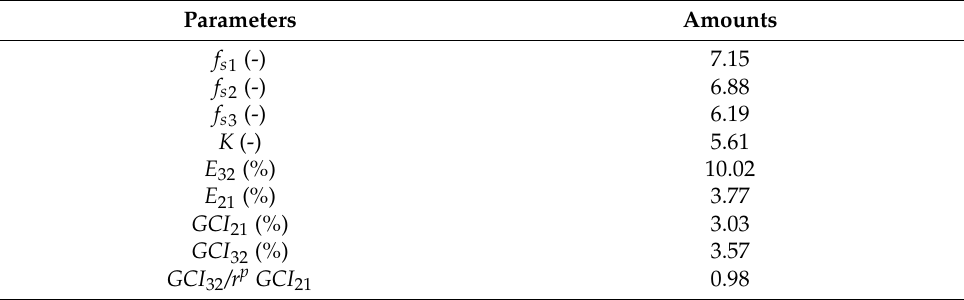
Table 5. The numerical results of mesh convergence analysis.